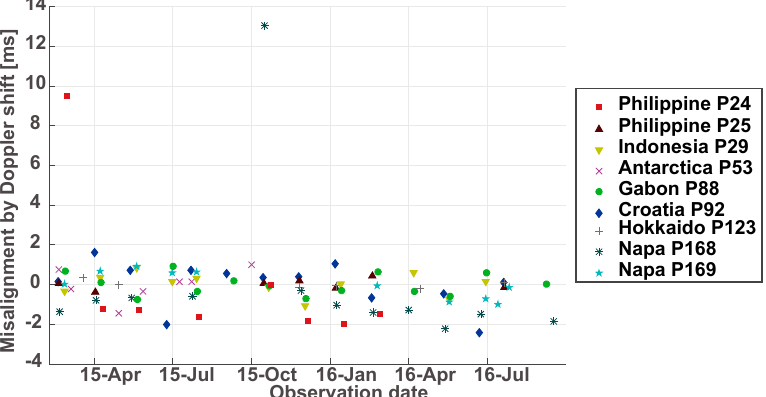
Figure 1. Positions of the sampled paths/frames. Figure 2 shows the misalignment plot caused by the Doppler shift. Two large shifts,